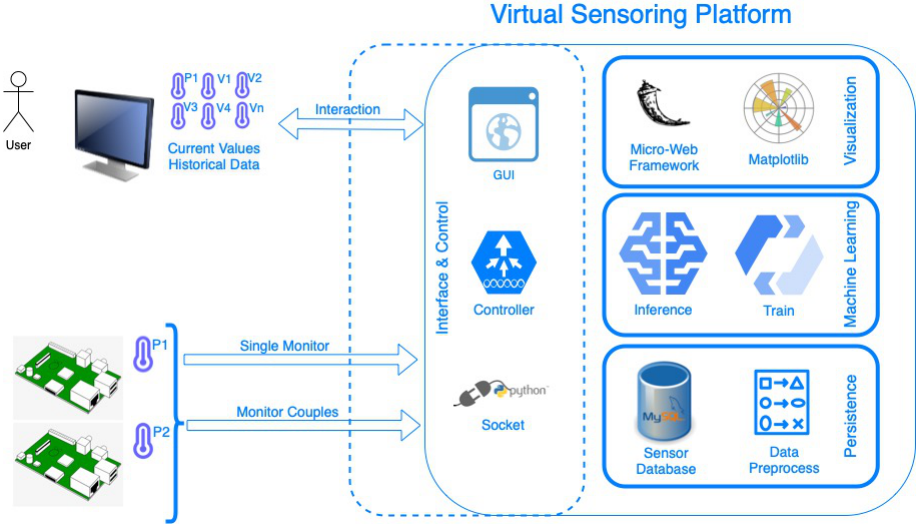
Figure 6. Architecture of the IoT